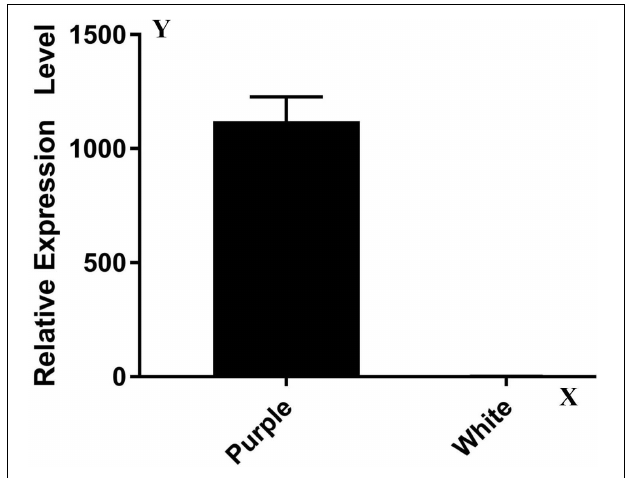
FIGURE 3 | Expression levels of genes Rs392880 in ZYR1 and HYR3. The x-axis displays different cultivars. The y-axis displays the relative transcription level of the Rs392880 gene compared with